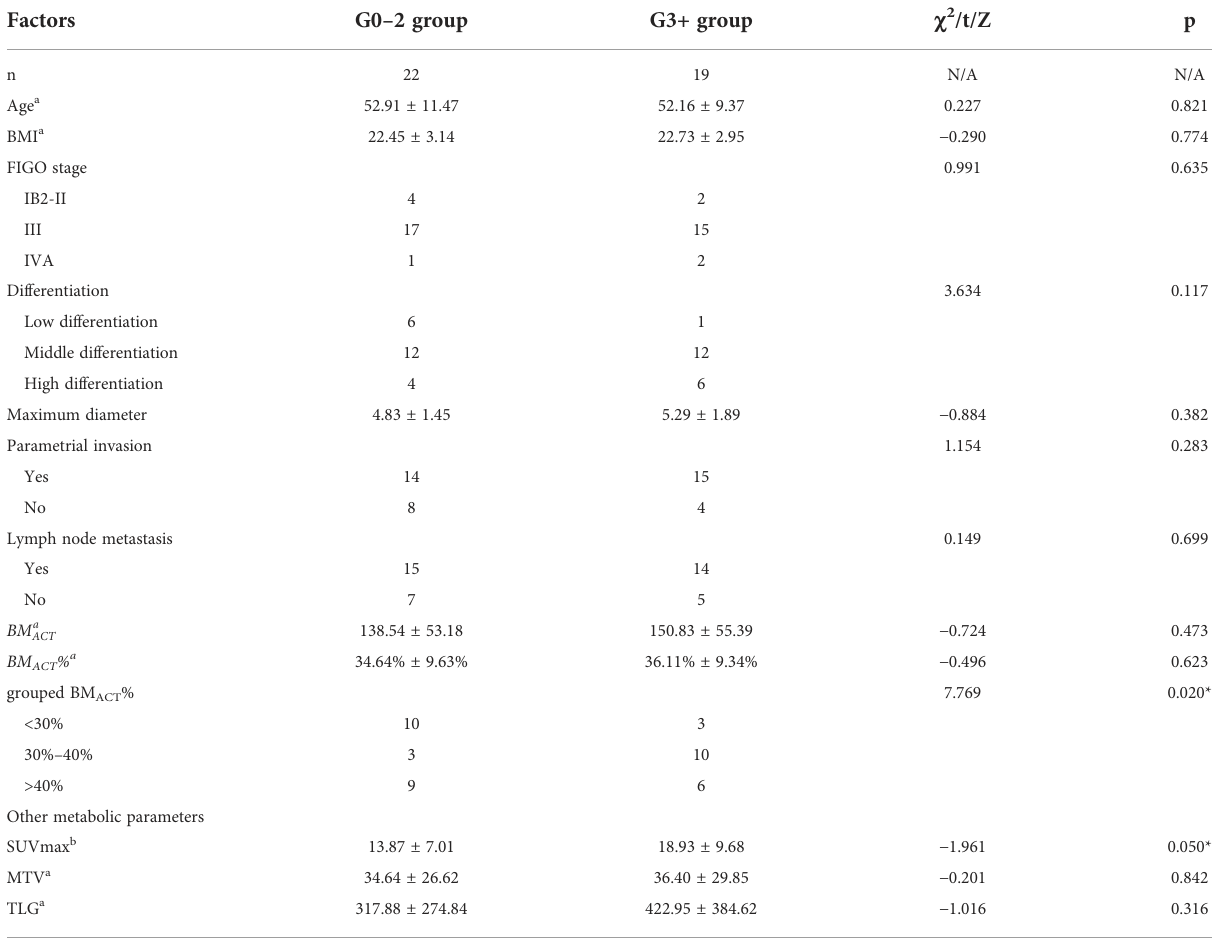
TABLE 3 Univariate analysis of HT during chemoradiotherapy.